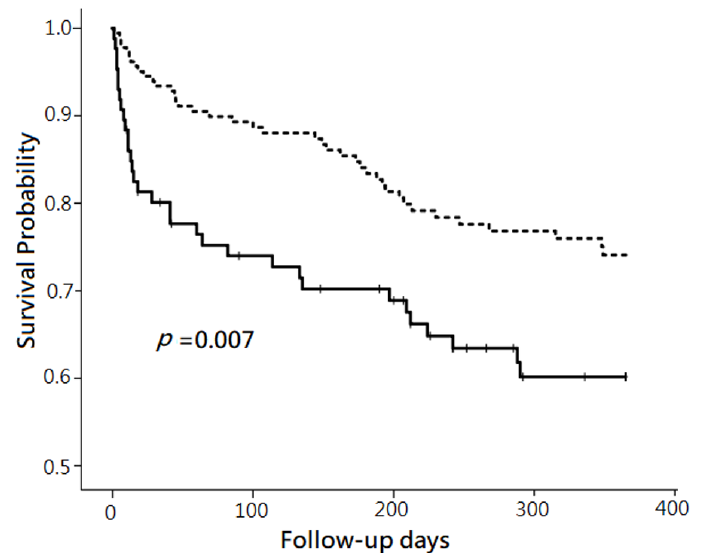
Figure 2. Comparison of 12-month mortality between two groups categorized by plasma N-terminal pro-brain natriuretic peptide (NT-proBNP) levels. Note: The comparison was performed without risk factor adjustment using the Kaplan–Meier method. The patients with plasma NT-proBNP ≧ 11,755 ng/L (solid line) had significantly lower survival probability than those with plasma NT-proBNP <11,755 ng/L (dashed line) after follow-up for 12 months ( p =